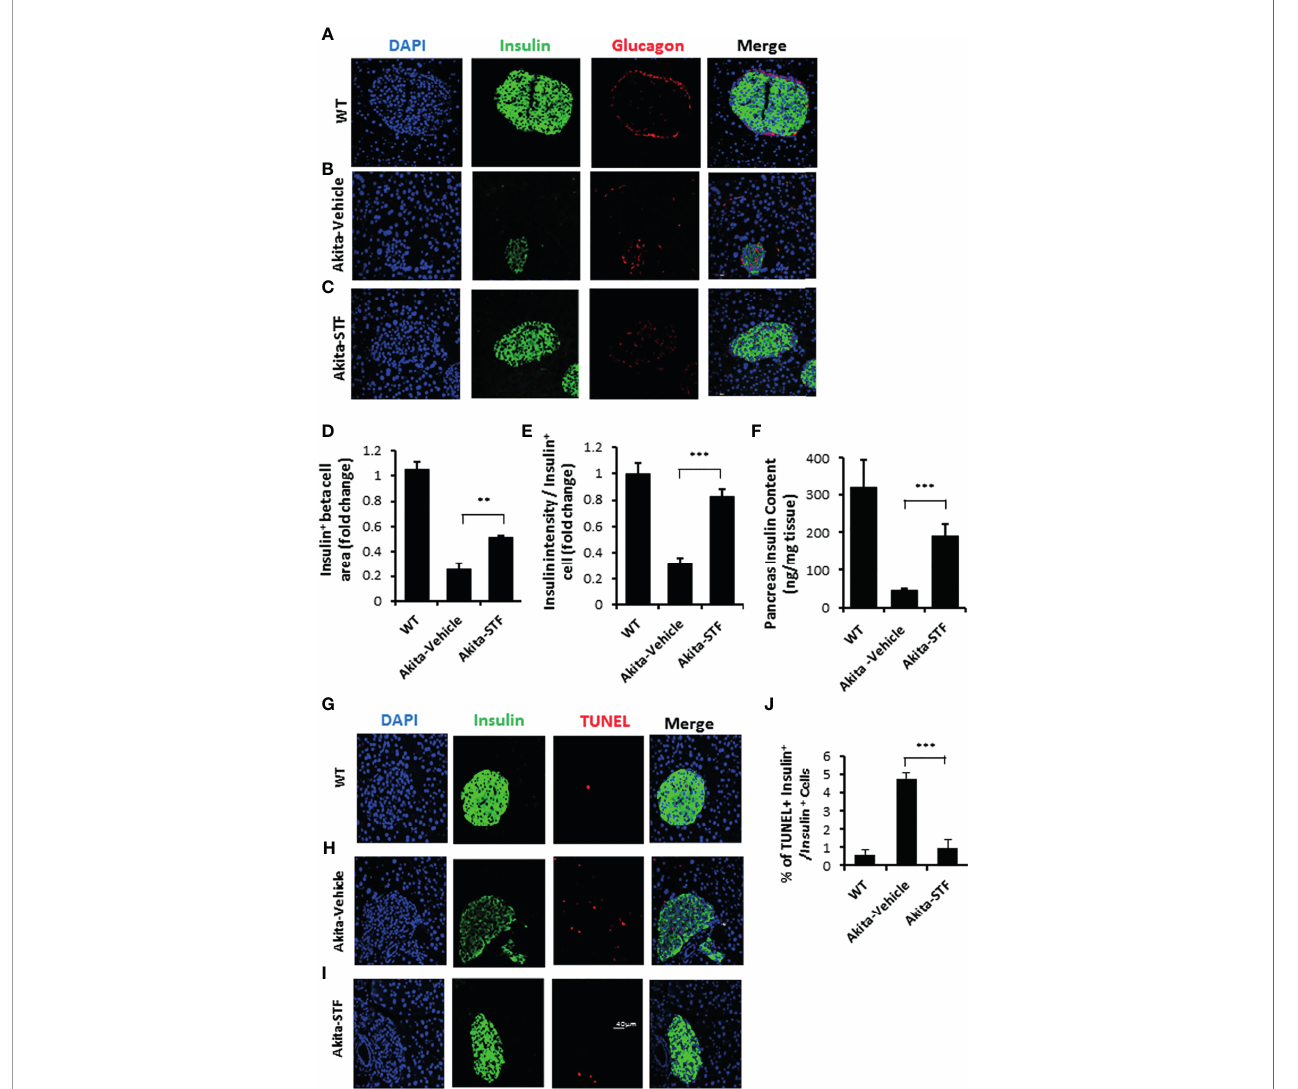
FIGURE 4 | STF preserves b -cell mass and viability and suppresses b -cell apoptosis in Akita mice. (A-C) Immuno fl uorescence staining of pancreatic sections. Pancreases were sectioned and slides were stained with anti-insulin antibody (green, b -cell marker), anti-glucagon antibody (red, a -cell marker), and DAPI (blue). Slides were imaged with an Olympus FV1000 confocal microscope. (D) Quanti fi cation of insulin + b -cell area after normalized to that for C57B/6 mice. (E) Insulin staining intensity. The average insulin staining intensity was quanti fi ed using ImageJ and normalized with that for C57B/6 mice designated as 1. (F) Insulin content measurement by ELISA as detailed in Methods and Materials. (G – I) TUNEL staining in pancreatic sections. Pancreatic sections were stained with anti-insulin antibody (green, b -cell marker), TUNEL (red, cell death), and DAPI (blue). Slides were imaged with an Olympus FV1000 confocal microscope. (J) Quanti fi cation of percentage of TUNEL + insulin + b -cells/insulin + cells. At least 50 islets were counted for each group. Data are the mean± SEM. **P < 0.01 and ***P <